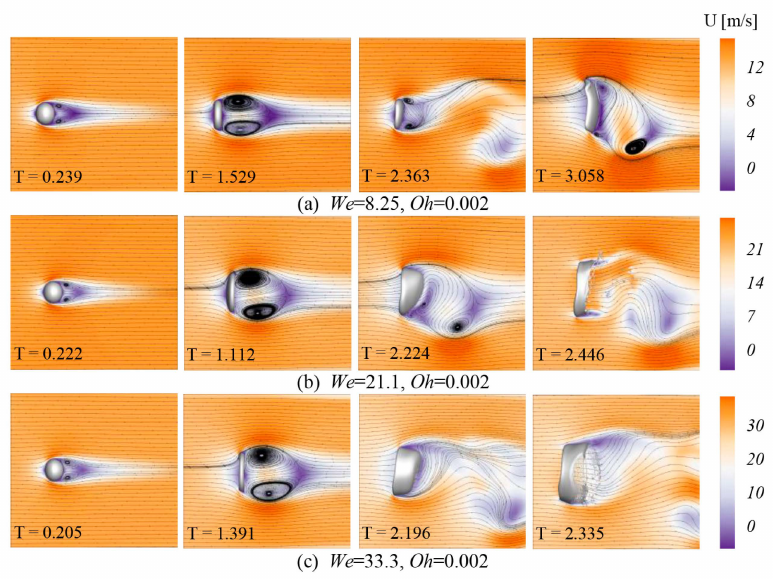
Figure 8. Velocity field under di ff erent We numbers ( Oh = 0.002). ( a ) We = 8.25; ( b ) We = 21.1; ( c ) We = 33.3.